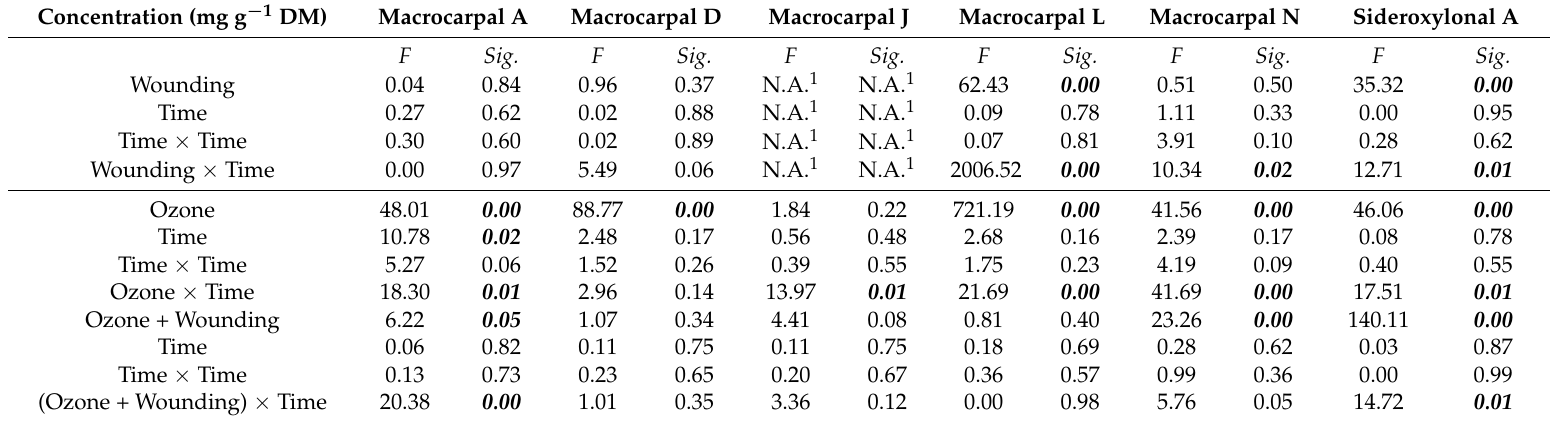
Table 2. Summary of the linear mixed model for the statistical effects of treatments (wounding, O 3 , and O 3 + wounding) and different recovery times on the concentration of individual FPCs in E. globulus leaves. Significant values are shown in italic and bold ( n = 3, Sig. <